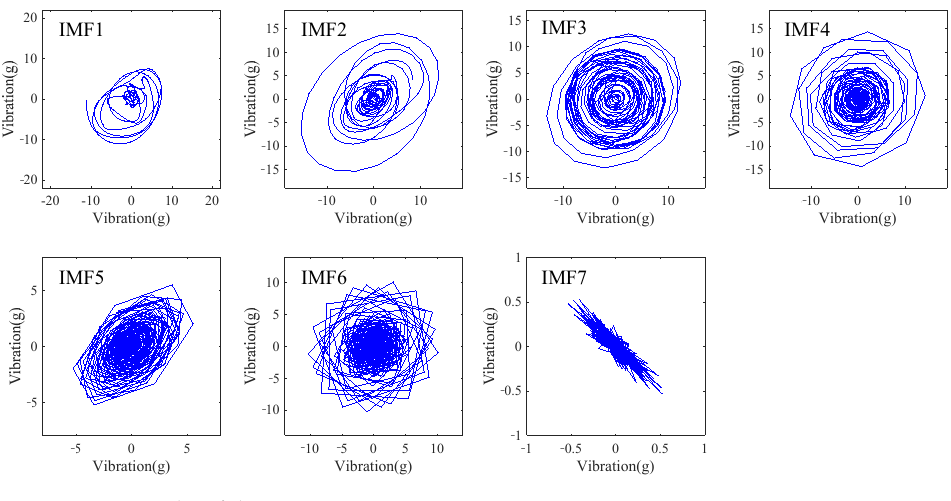
Figure 5. PSR results of the IMFs.